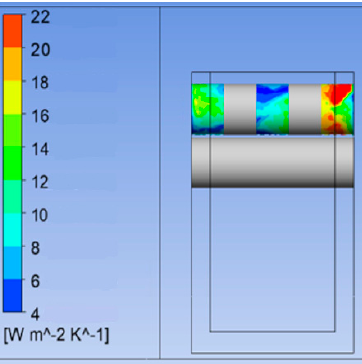
Figure 6. Distribution of the heat transfer coefficient on the cells’ surface ( a ) with visible battery segment housing; ( b ) with hidden battery segment housing.